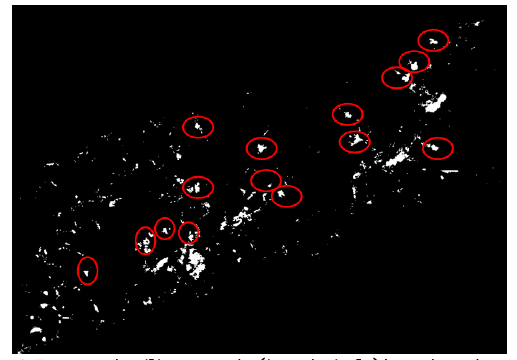
Fig. 6 Extracted tailings ponds (in red circle) based on thermal